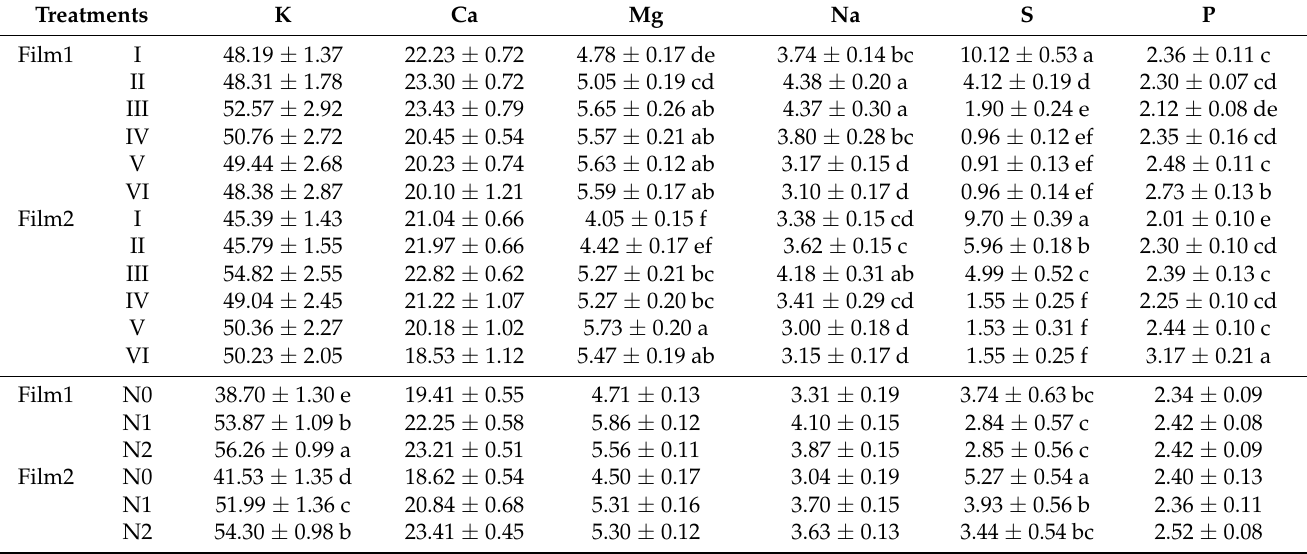
Table 4. Interactions plastic film × harvest (P × H) and plastic film × nitrogen fertilization (P × F) on the average mineral content of rocket (g kg − 1 dw). Different letters within each column indicate significant differences at p = 0.05 (Tukey’s